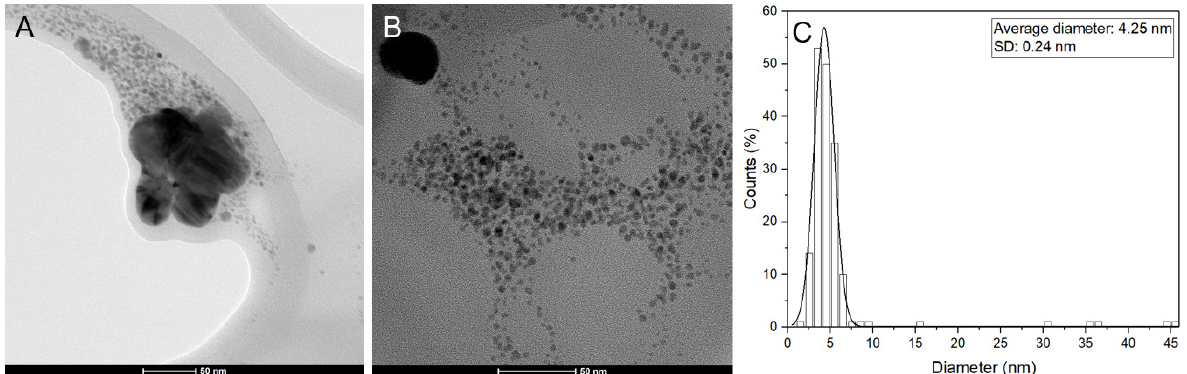
Figure 6. Characterization of the AgNPs synthesized with orange peel extract. ( A ) TEM micrograph of the AgNPs. ( B ) High-resolution TEM micrograph of the AgNPs. ( C ) Histogram showing the particle size distribution.